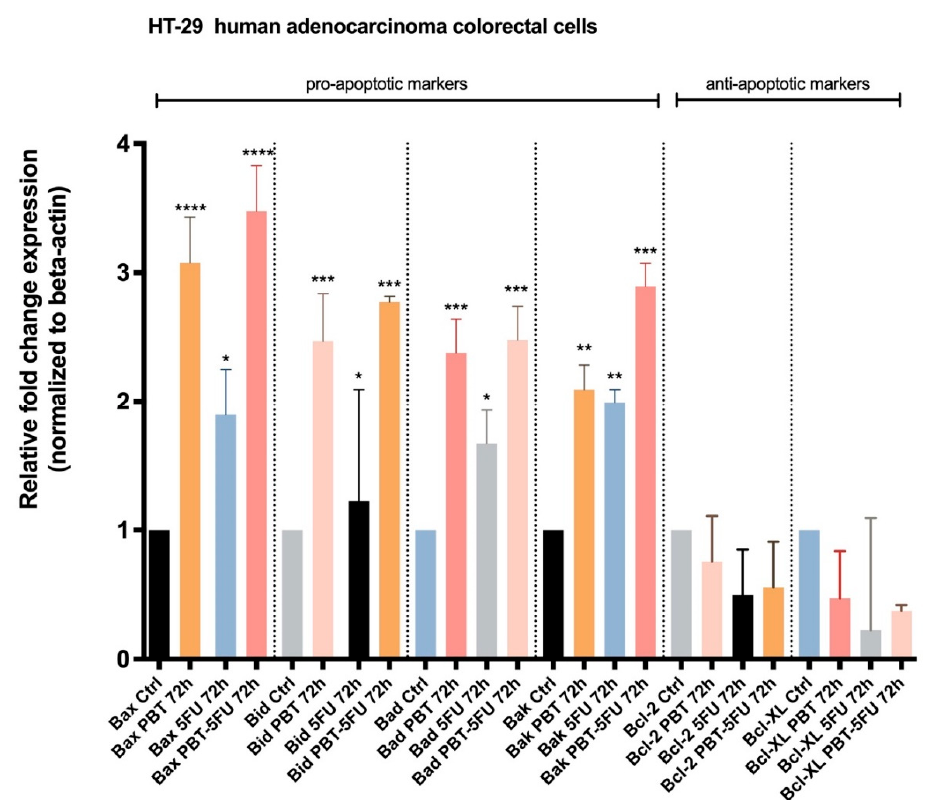
Figure 5. Relative fold change expression of mRNA of pro-apoptotic (Bax, Bid, Bad, and Bak) and anti-apoptotic (Bcl-2 and Bcl-XL) markers in human adenocarcinoma colorectal cells (HT-29)—72 h after exposure to PBT, 5FU, and PBT-5FU. mRNA expression levels normalized to beta-actin expression; mean values ± SD of three independent experiments presented; one-way ANOVA with Tukey’s post-test used to identify the statistical differences (* p < 0.05, ** p < 0.01, *** p < 0.001, and **** p < 0.0001).